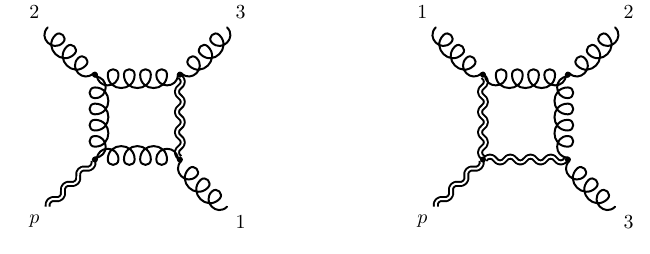
Figure 15 . The box graphs in the three-gluon amplitude at order κ 3 g given by